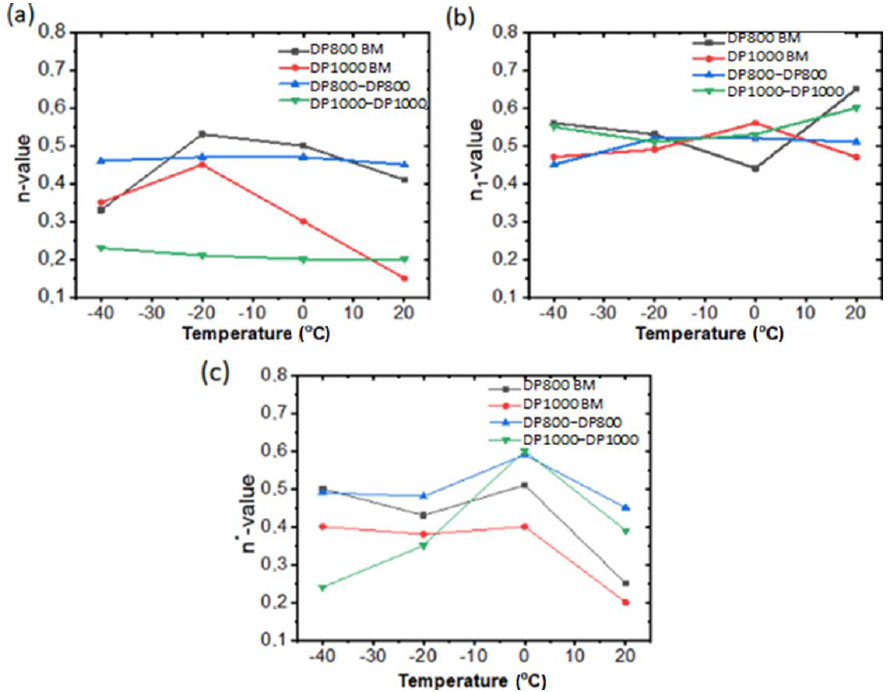
Figure 10. Strain hardening exponents based on ( a ) Hollomon equation, ( b ) J − C analysis, and ( c ) equation proposed by Afrin et al. [76] determined at different deformation temperatures for the base metals and welded joints.